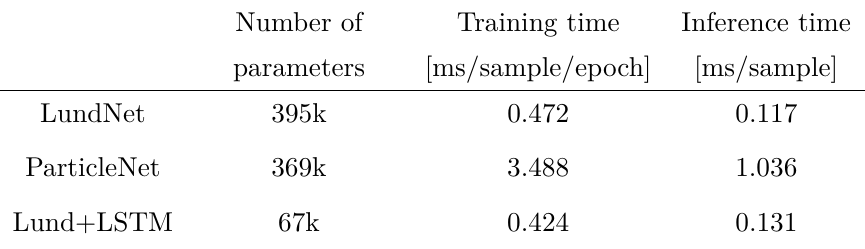
Table 2 . Summary for each model of the number of parameters, training time per sample and epoch, and inference time per sample. The time is measured in milliseconds as obtained when running the models on an Nvidia GTX 1080 Ti card.